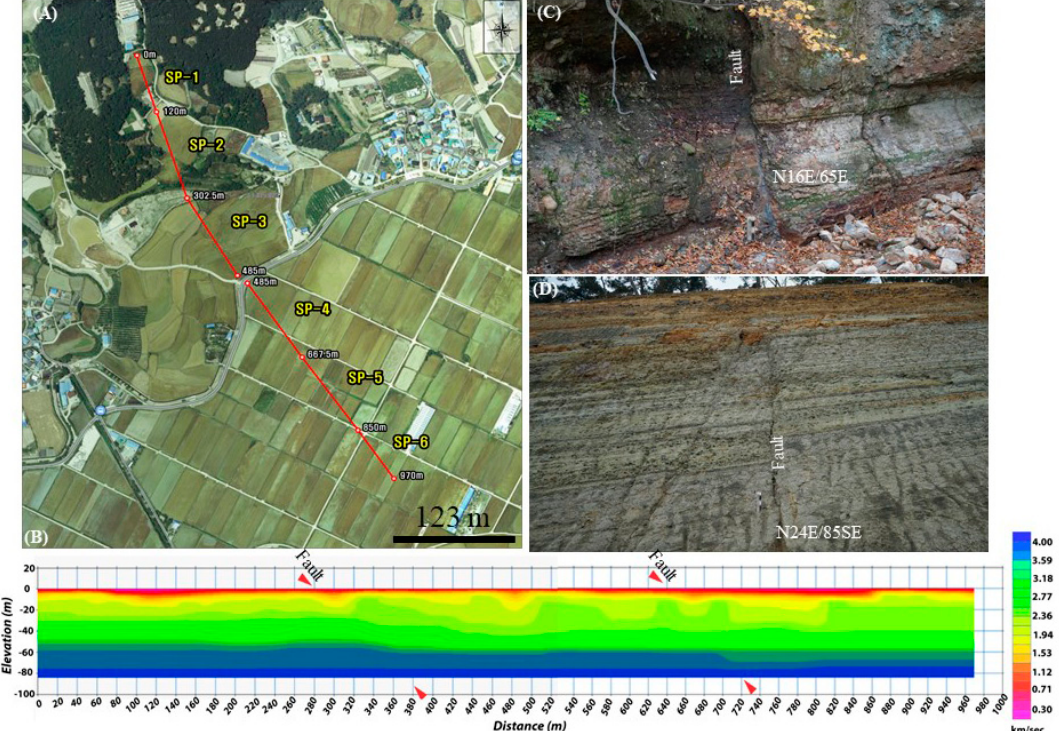
Figure 11. ( A , B ) Seismic refraction profile showing existences of the south dipping normal fault within Heunghae basin, which could be the traces of Heunghae Fault (red arrow shows the traces of faults). ( C , D ) Field photographs showing evidence of normal faulting. The faults offset the tertiary deposits within the Heunghae basin.